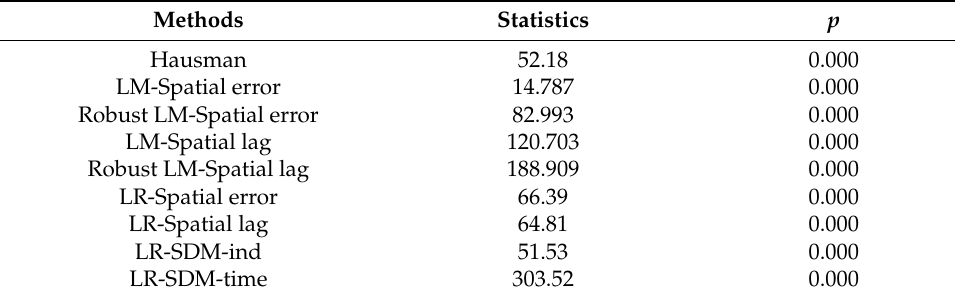
Table 3. Model selection test results.